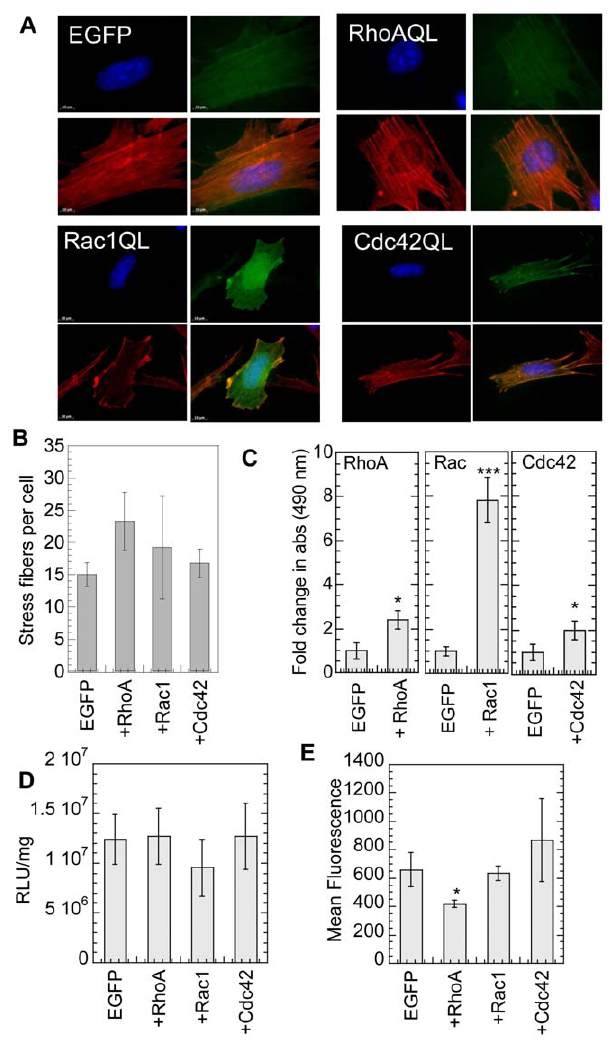
Figure 5. Effect of expression of constitutively active mutants of RhoGTPases on gene transfer. mMSCs plated on a 6-well plate were transiently transfected with constitutive active forms of RhoA, Rac1 or Cdc42 conjugated with GFP, using lipofectamine TM 2000. Cells transfected with pEGFP were used as control. After 24 hours, cells were harvested and replated on fibronectin-coated surfaces. ( A ) 24 hours post transfection with constitutive active forms of RhoGTPases in cells plated on tissue culture plastic, changes in cell morphology were analyzed through actin and DNA staining using Alexa488 conjugated phalloidin (green), and Hoechst 33258 dye (blue), respectively. ( B ) The number of stress fibers per cell were counted. ( C ) Active Rho, Rac and Cdc42-GTPases were assessed using GLISA assays 24 hours post transfection with constitutive active forms of RhoGTPases and overnight serum starvation. ( D ) The replated cells were cultured for 16 hours on fibronectin before bolus transfection. The transgene expression was analyzed 48 hours post transfection using luciferase assay and normalized with total protein analyzed using Peirce BCA assay. ( E ) Internalization was analyzed 2 hours post transfection using flow cytometry and YOYO-3 labeled polyplexes. A total of 10,000 events were analyzed per sample and the mean fluorescence of events positive for both GFP and YOYO-3 was analyzed. Statistical analysis for number of stress fibers, ruffles, transgene expression and internalization was done using the Dunnett multiple comparison test.